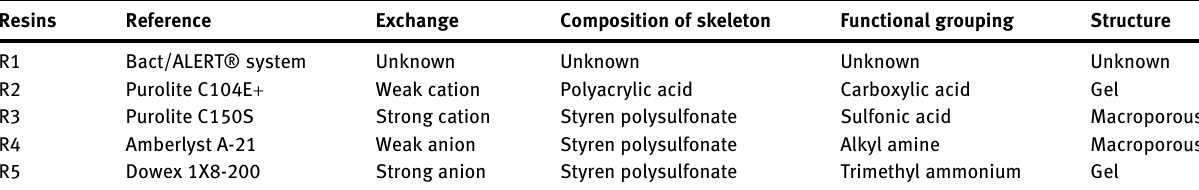
Table  : IER characteristics. Resins